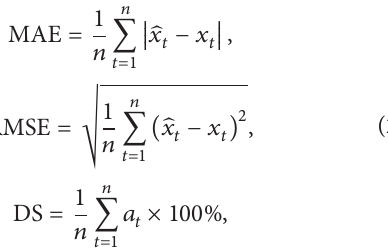
Figure 4: DVV scatter diagrams.